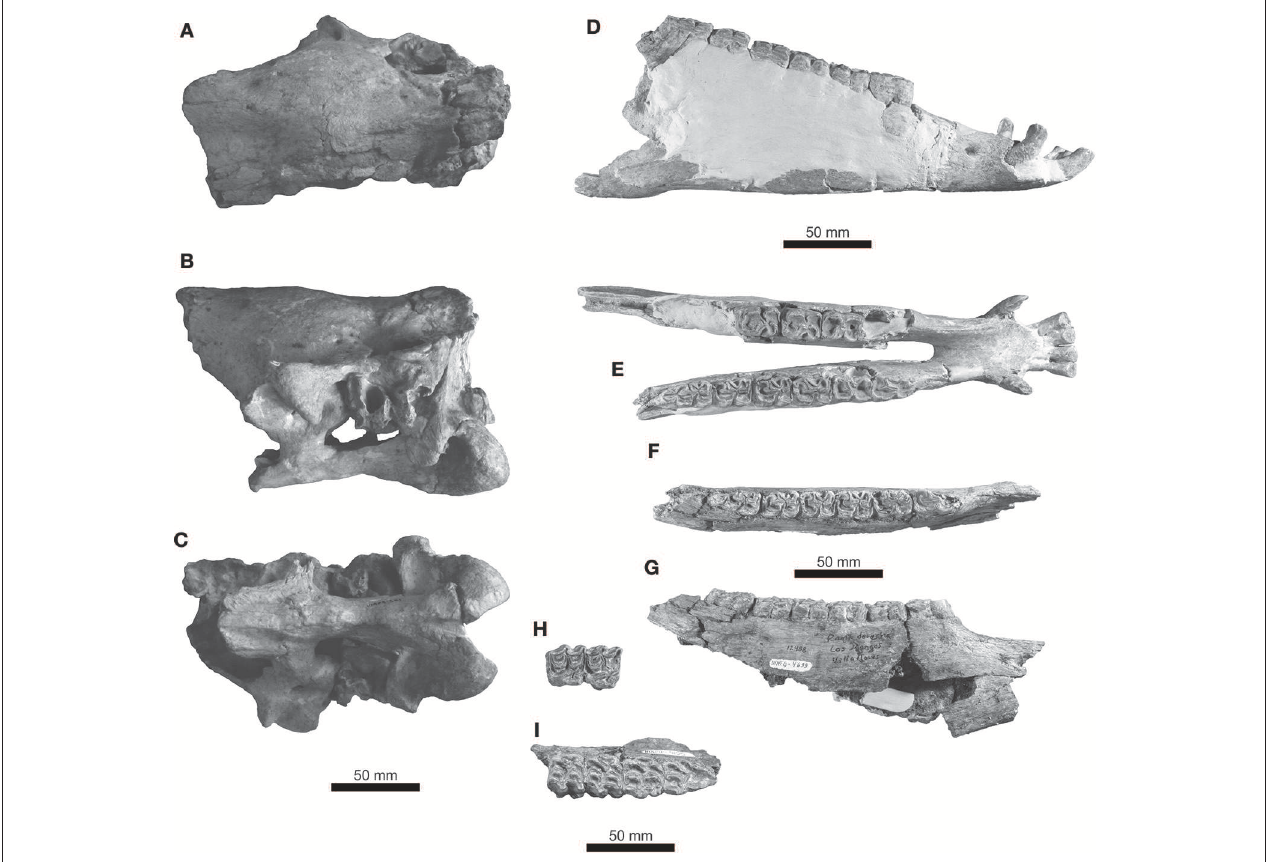
FIGURE 5 | Haringtonhippus francisci from southern Mexico. UMPE 561, basicranium in (A) dorsal, (B) lateral, and (C) ventral views. IHNFG-4211, mandible in (D) lateral and (E) dorsal views. IHNFG-4699, mandible in (F) lateral and (G) dorsal views. IHNFG-4155, right P4-M1 in (H) occlusal view and left P2-M1 in (I) occlusal view.